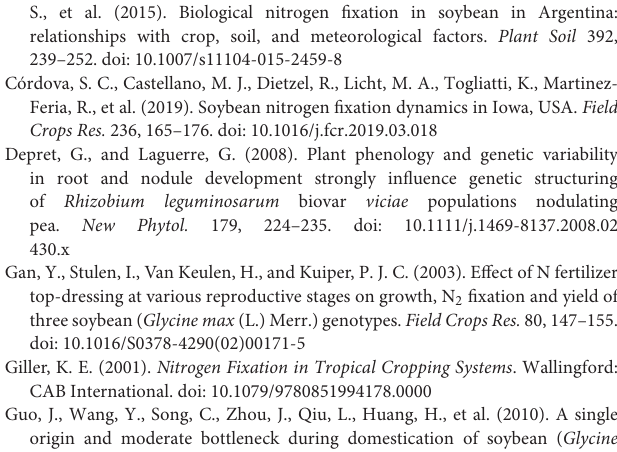
Supplementary Figure 1 | Pedigree relationships of the 44 historical and modern-Guelph accessions tracing back to historical founder accessions, plotted by year of release (cultivars). Blue shows historical cultivars, while red shows modern-Guelph cultivars. Data from: (Bruce et al., 2019b). Supplementary Figure 2 | Trait by year of cultivar release regression plots for pre-pod-fill agronomic traits. (A,B) Root dry weight per plant. (C,D) Shoot dry weight per plant. (E,F) Shoot N%. (G,H) Shoot C/N ratio. (I,J) Total shoot nitrogen content. Each blue and purple dot represents a historical and modern-Guelph variety, respectively. NS, not significantly different at p < 0.05.